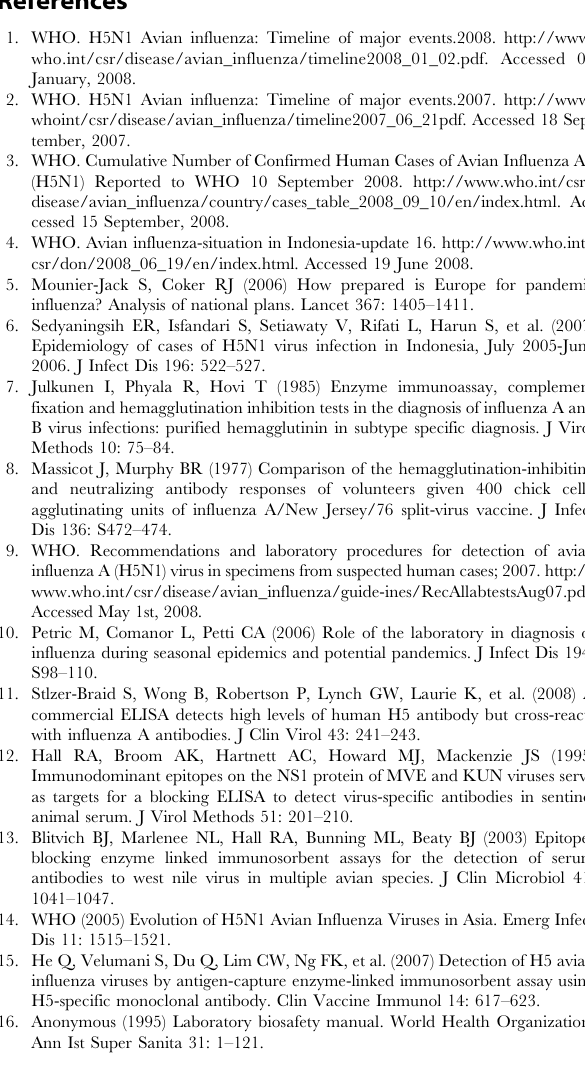
Found at: doi:10.1371/journal.pone.0004566.s001 (0.03 MB DOC) Found at: doi:10.1371/journal.pone.0004566.s002 (0.03 MB DOC) Found at: doi:10.1371/journal.pone.0004566.s003 (0.03 MB DOC)